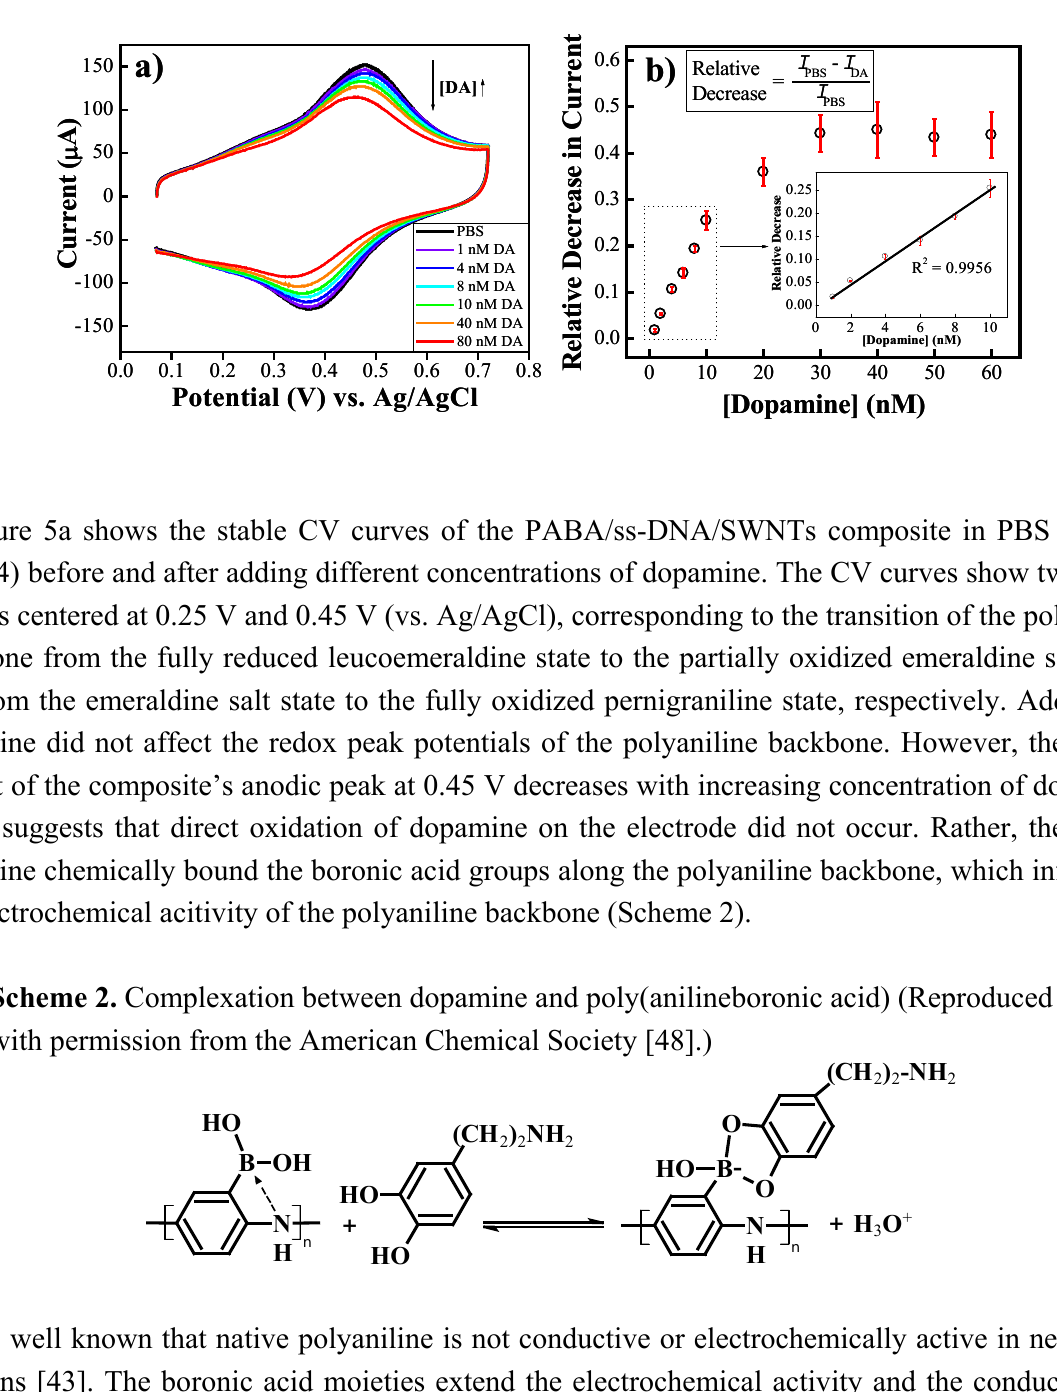
Figure 5. (a) Cyclic voltammograms of the composite in PBS and in the presence of different concentrations of dopamine; (b) a correlation curve of the data presented in 1a (n=5). Potential scan rate: 100 mV  s -1 . (Reproduced with permission from the American Chemical Society